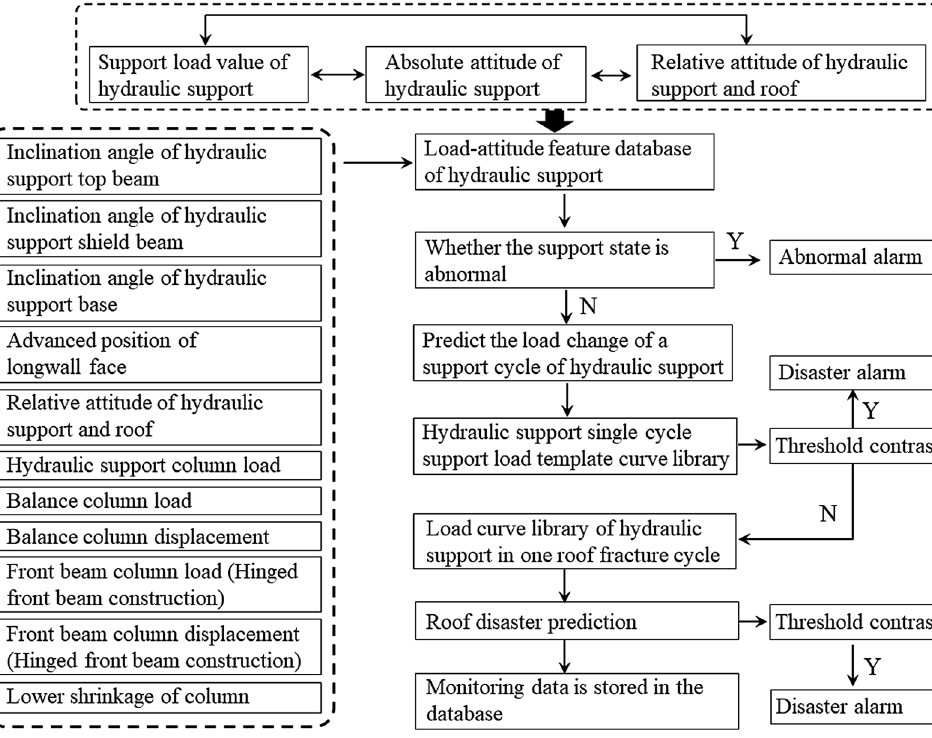
Fig. 15 Technical framework of the intelligent prediction platform for roof